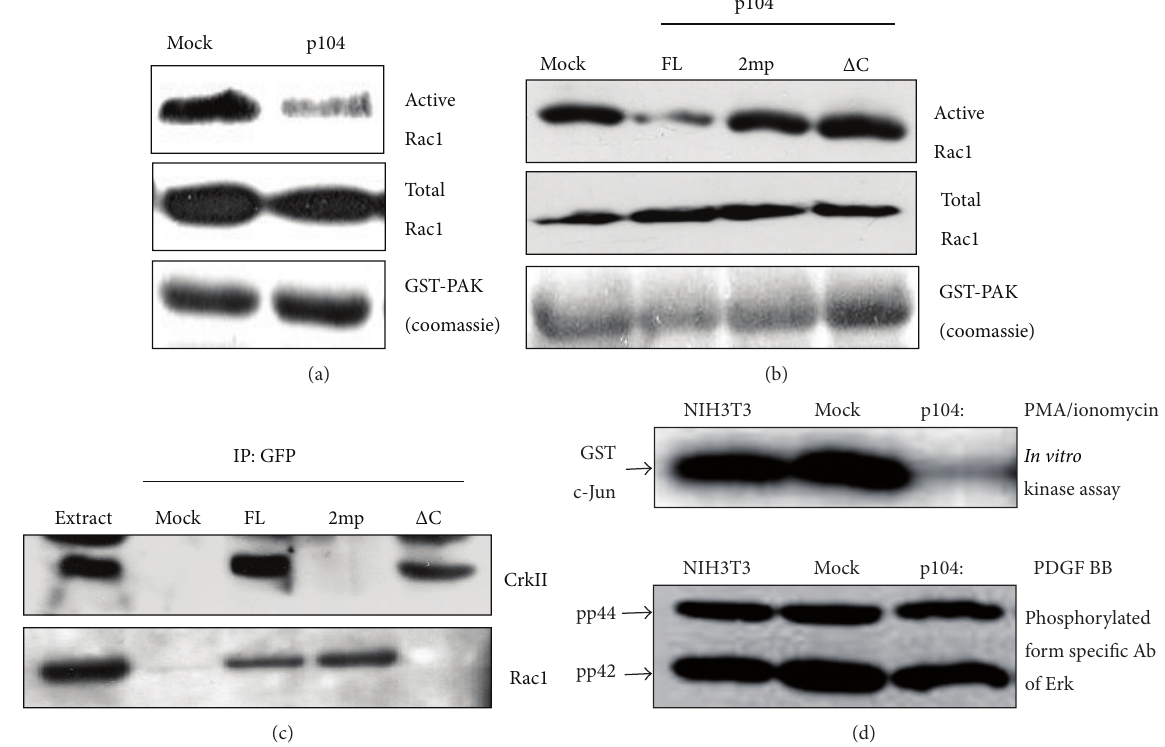
Figure 4: The interaction of p104 with CrkII decreased the activity of Rac1. (a) NIH3T3 cells were transfected with empty vector (Mock) or p104 constructs. After 24 h of transfection, the amount of GTP-bound (active) Rac1 was determined by GST-PAK pull-down analysis, followed by Western blotting with an anti-Rac1 antibody (upper panel). 50 𝜇 g of cell lysate was used for Western blot analysis with an anti- Rac1antibodytocheckthetotalamountofRac1(middlepanel).TheamountofGST-PAKusedinthisassaywasassessedbycoomassiebrilliant blue staining (bottom panel). (b) NIH3T3 cells were transfected with GFP-tagged full-length p104 (FL), second proline-rich motif mutant (2mp) and carboxy-terminal deletion mutant ( Δ C). The level of GTP-bound Rac1 was measured by GST-PAK pull-down analysis, followed by Western blotting with anti-Rac1 antibody. (c) Lysates from NIH3T3 cells transfected with GFP-tagged full-length p104, 2mp mutant, and carboxy-terminal deletion mutant were immunoprecipitated with an anti-GFP antibody, and then Western blot analysis was performed with anti-CrkII (upper panel) and anti-Rac1 antibodies (lower panel). (d) Inhibition of JNK activity by p104 overexpression. To measure the JNK activity, cells were serum-starved for 12 h and then treated with 5 𝜇 M PMA/ionomycin for 5 min. JNK was immunoprecipitated and kinase assays were performed using GST c-Jun as a substrate (upper panel). After treatment with 50 ng/mL PDGF BB, 50 𝜇 g of each cell lysate was separated on SDS-PAGE gel and they were analyzed by Western blot using an anti-active ERK antibody to check the Erk activity (lower